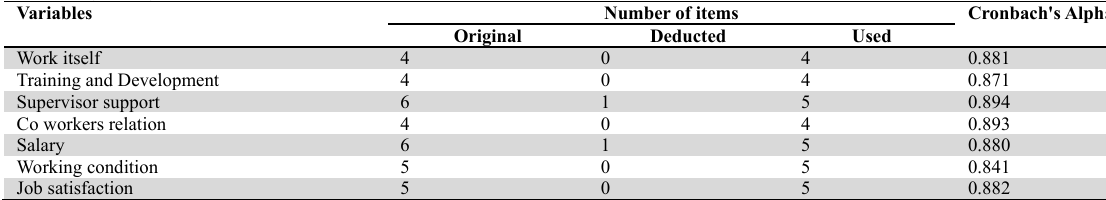
Reliability analysis